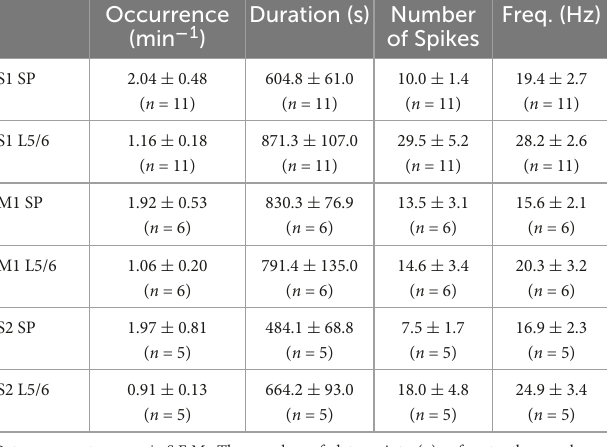
TABLE 3 Properties of the burst discharges induced by the low Mg 2 + solution at the different recording sites.